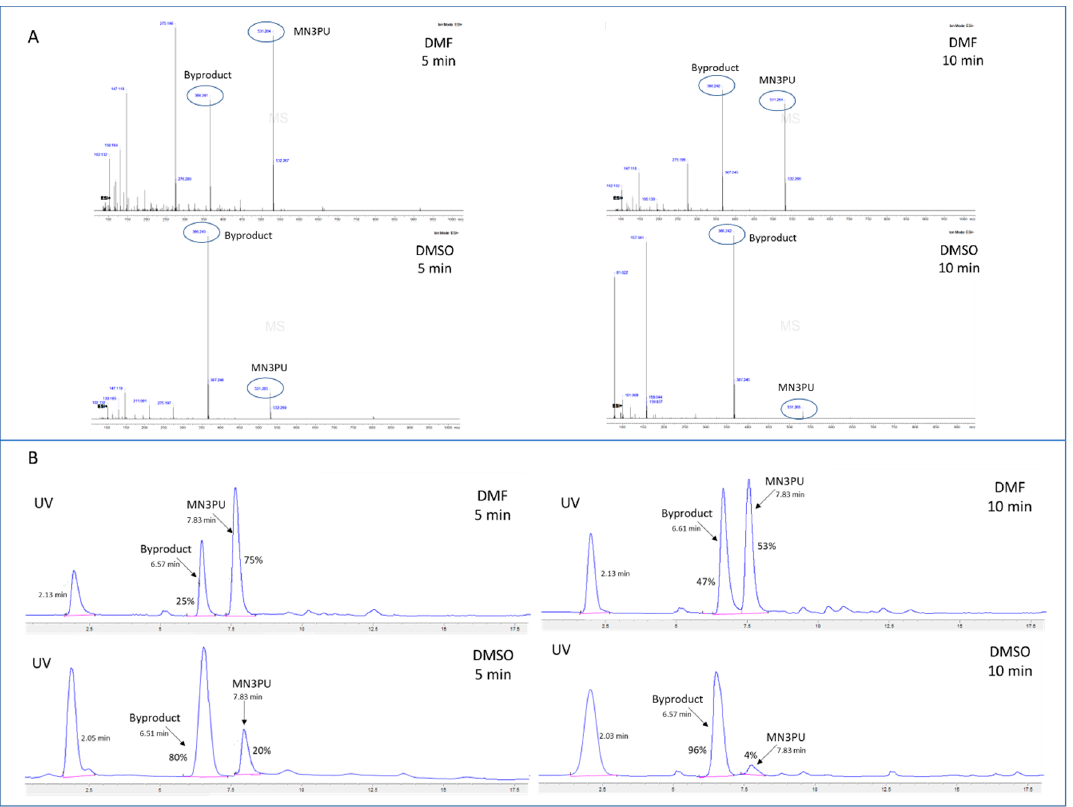
Figure 1. ( A ) LC/MS (+ESI) mass spectra analysis of aliquots from a solution containing MN3PU (compound 3 ) in 500 μ L of DMF after heating at 110 °C for 5 or 10 min shows rapid thermolysis of precursor in DMSO compared to DMF (MN3PU ( 3 ) mass: 531.26 [M + H] + ; Byproduct ( 6 ) mass: 366.24 [M + H] + ); ( B ) HPLC chromatograms demonstrating byproduct formation from heated MN3PU ( 3 ) in DMF or DMSO after 5 and 10 min (eluent (51% ACN in water (0.1% TFA), Phenomenex Luna (250 × 4.6 mm), Flow rate (1 mL/min) for 20 min, UV (254 nm)); (UV peak at 2.3 min might be of 2-nitro-4-aminopyridine).